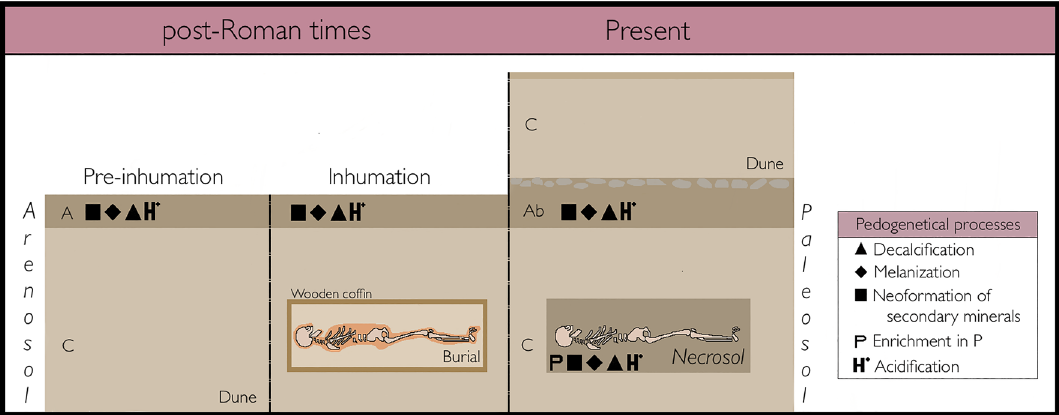
Figure 5. Diagram of the Necrosol pedogenesis compared with that of the buried epipedon of the